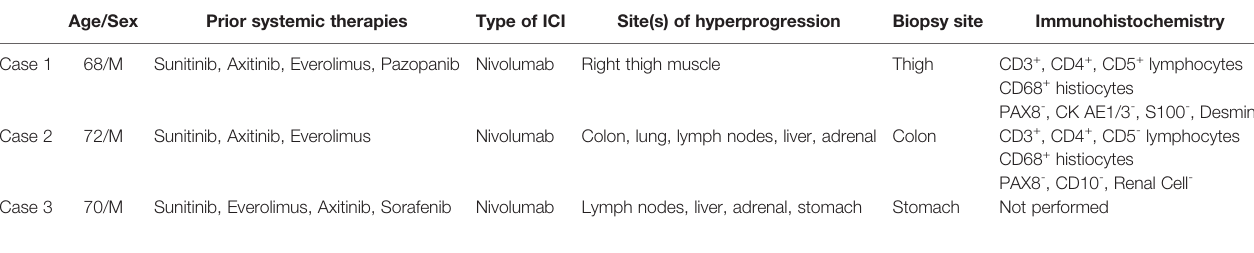
TABLE 1 | Description of clinical and pathological characteristics of the three